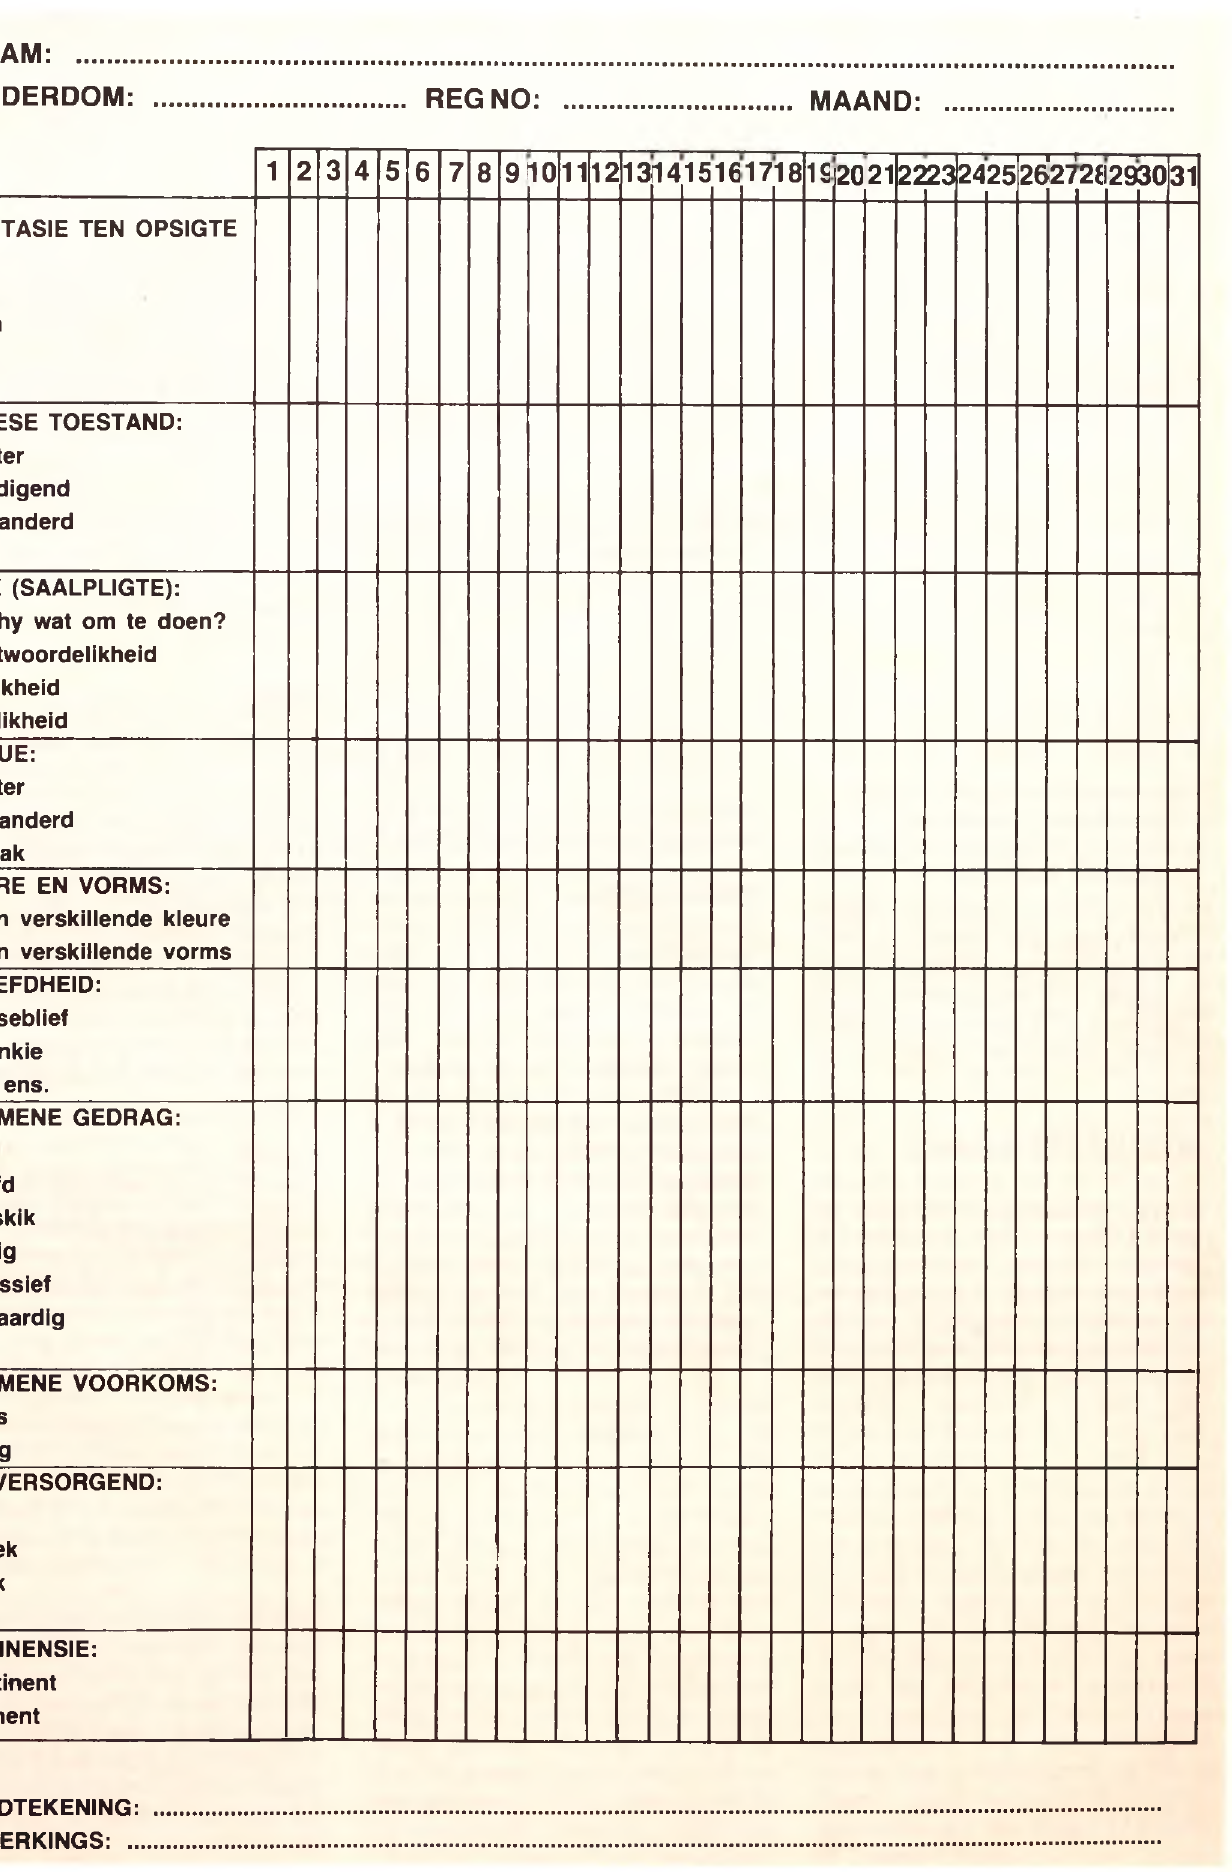
TABEL 1: VOORBEELD VAN EVALUASIE VORM NAAM: